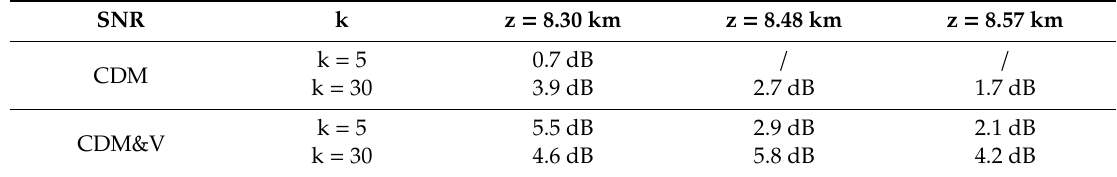
Table 3. Comparison of synthesized signal between the CDM and